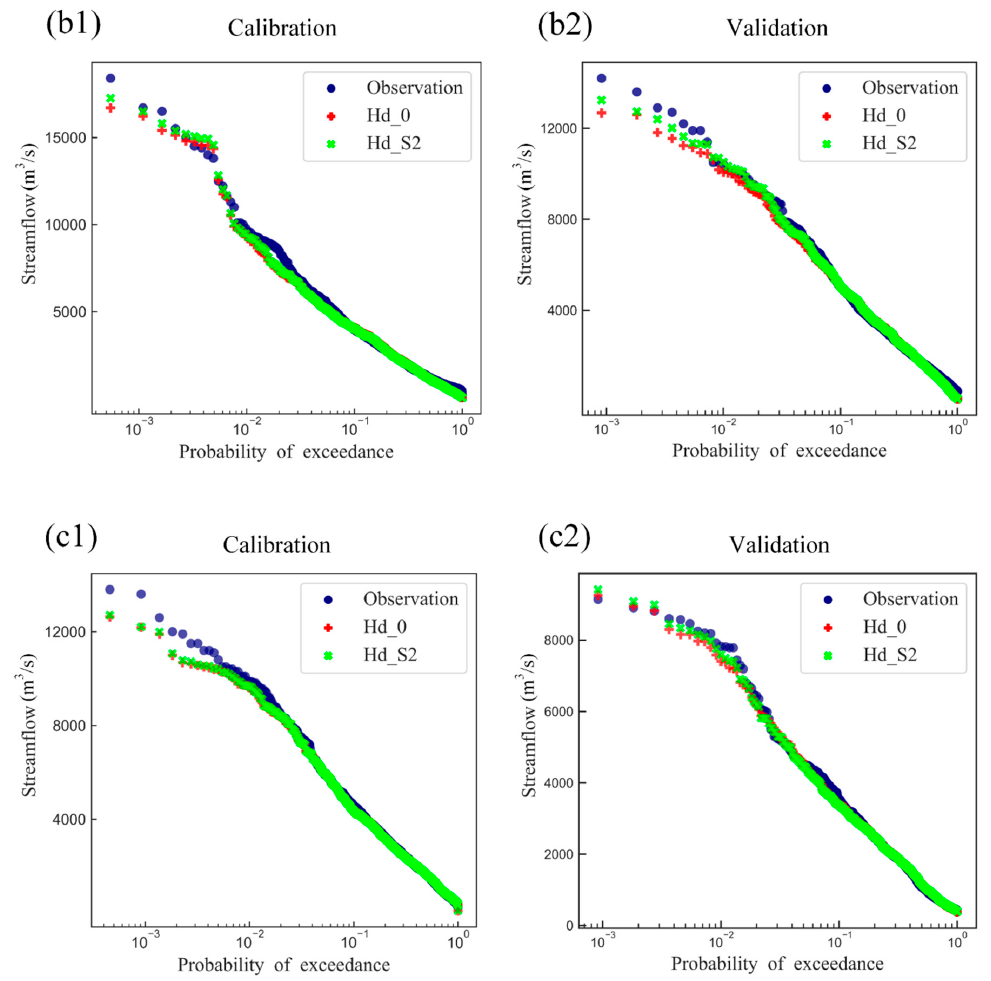
Figure 8. Flow duration curves for observed and modeled streamflow at ( a ) the Hanjiang River catchment, ( b ) the Xiangjiang River catchment, and ( c ) the Ganjiang River catchment during the calibration period (left) and validation period (right).